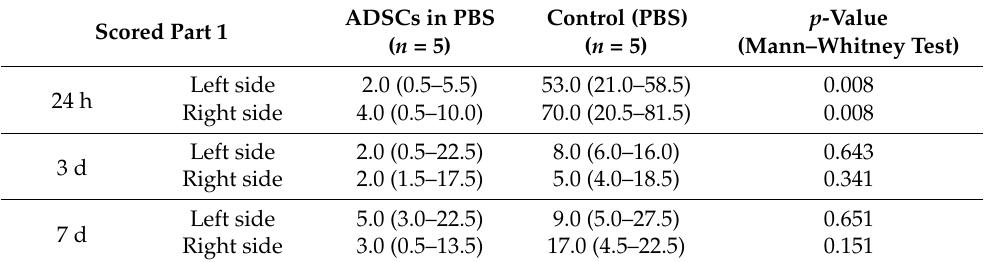
Table 3. Immunohistochemical analysis of paired box 6 (PAX6) expression in the olfactory epithelium of mice 24 h, 3 d, and 7 d after left side nasal administration of ADSCs or